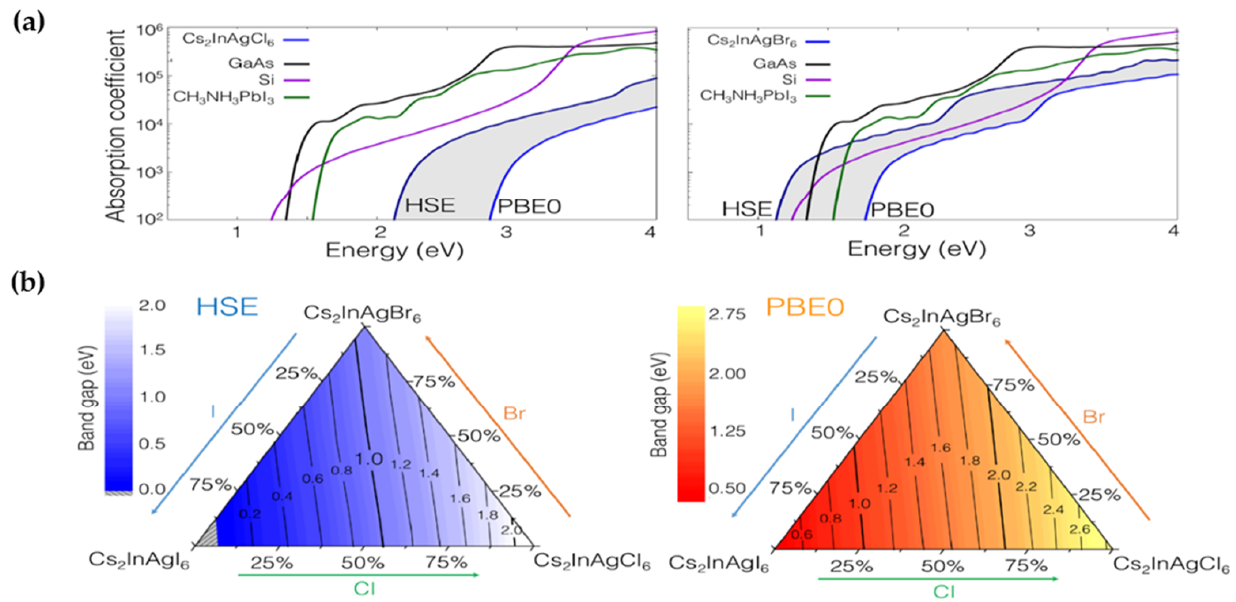
Figure 18. ( a ) Calculated absorption coefficient of the synthesized compound, Cs 2 InAgCl 6 , and hypothetical compound, Cs 2 InAgBr 6 , compared with the theoretical absorption coefficients of Si, GaAs and MAPbI 3 ; ( b ) Calculated band gaps of hypothetical mixed-halide double perovskites Cs 2 InAg (Cl 1 − x − y Br x I y ) 6 within the HSE (left) and PBE0 (right) hybrid functional. The corners of the triangle correspond to Cs 2 InAgX 6 with X = Cl, Br, I. Reproduced with permission from [118]. Copyright 2017, American Chemical Society.